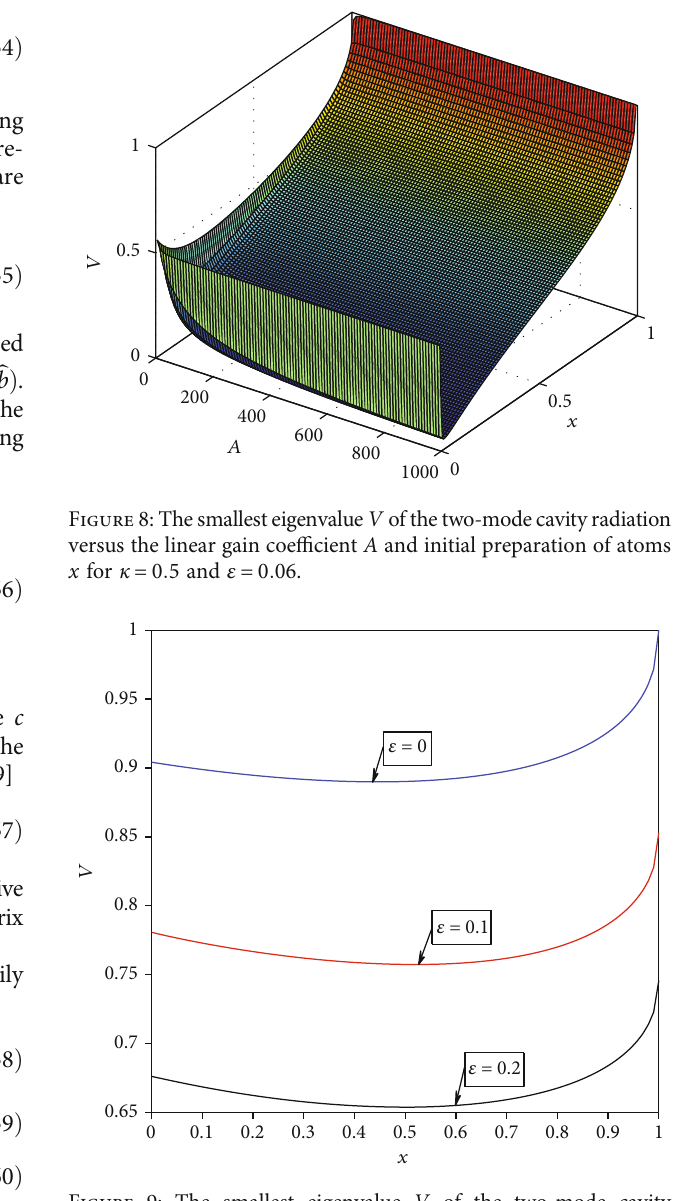
Figure 9: The smallest eigenvalue V of the two-mode cavity radiation versus x for A = 0 : 5 , κ = 0 : 9 , and di ff erent values of ε